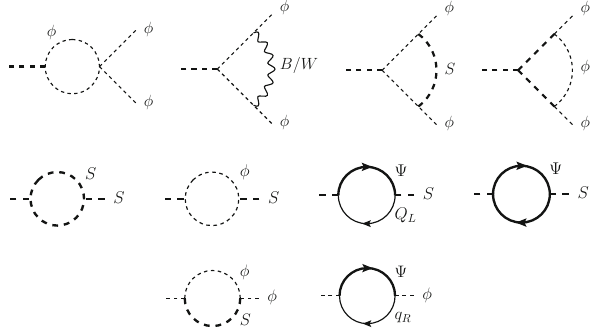
Fig. 6 One-loop diagrams contributing to the parameter δ κ graphs in the last two lines show the matching corrections to the wave- function renormalization constants of the heavy resonance S and the Higgs scalar φ